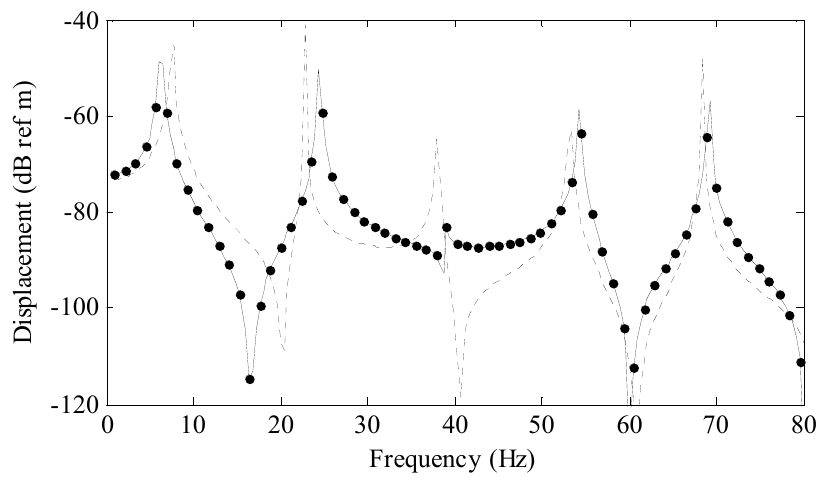
Figure 5. Displacement versus frequency for a rod with a triangular variation of cross-sectional area. The solid line is the series solution, the circular markers are the analytical solution and the dashed line is the baseline model with uniform cross-sectional area. Appl. Sci. 2018 , 8 , 94